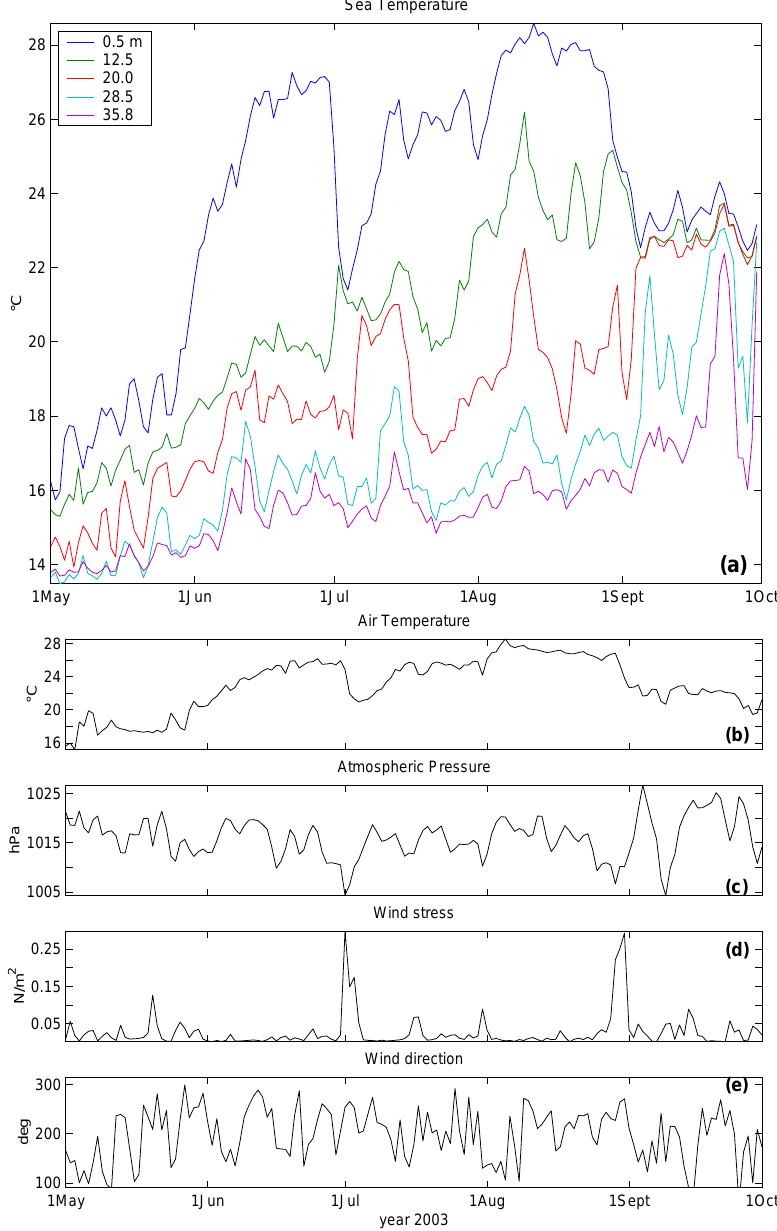
Fig. 4. Daily averaged time series from May to September 2003 of (a) the sea temperature at five depth levels, (b) the air temperature, (c) the atmospheric pressure, (d) the surface wind stress, and (e) the wind